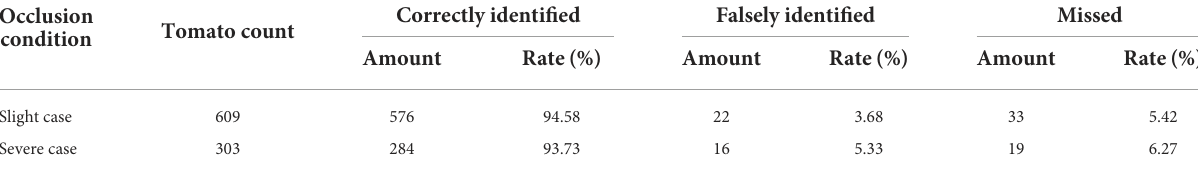
TABLE 5 Performance of the proposed TomatoDet under different occlusion